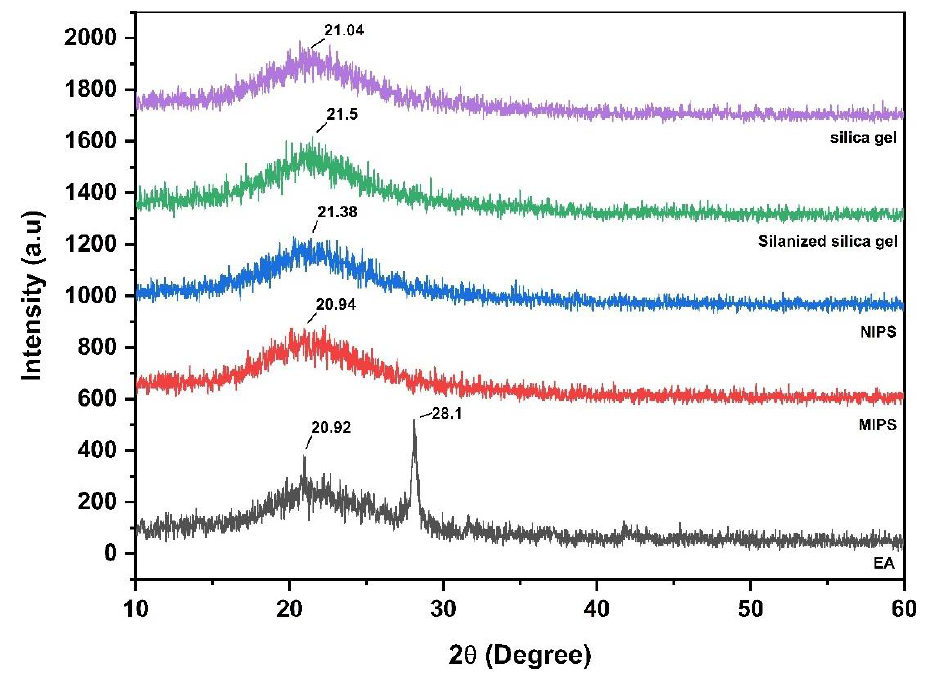
Molecules 2022 , 27 , x FOR PEER REVIEW Figure 3. XRD patterns of silica gel, silanized silica gel, MIPs, NIPS, and EA. Figure 3. XRD patterns of silica gel, silanized silica gel, MIPs, NIPS, and EA